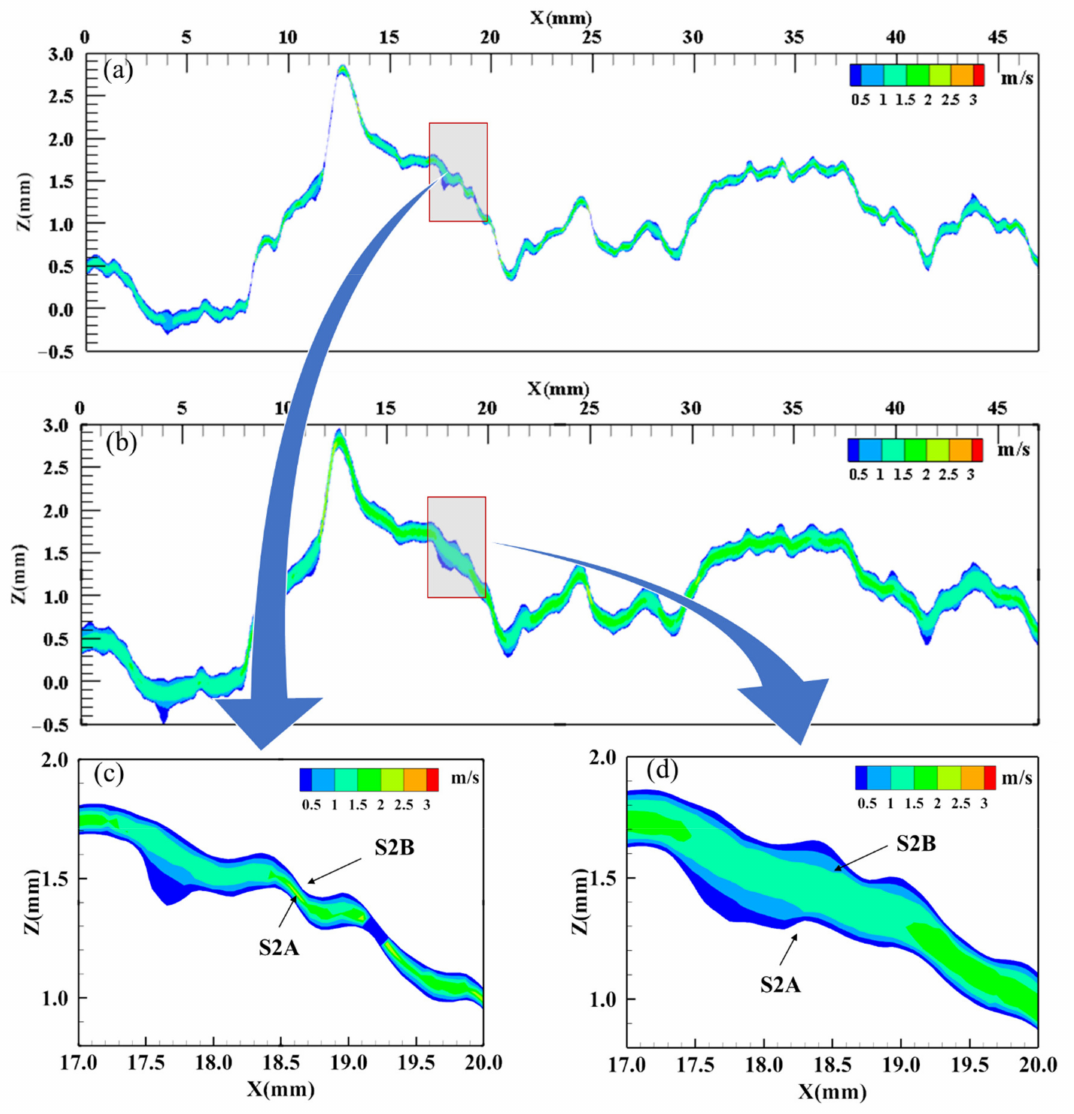
Figure 17. Numerical simulation of fluid flow in actual fracture model by Fluent 16.0. ( a ) Fracture before leaching, ( b ) fracture after leaching, ( c ) enlarged view of X = 17 − 20 mm before leaching and ( d ) enlarged view of X = 17 − 20 mm after